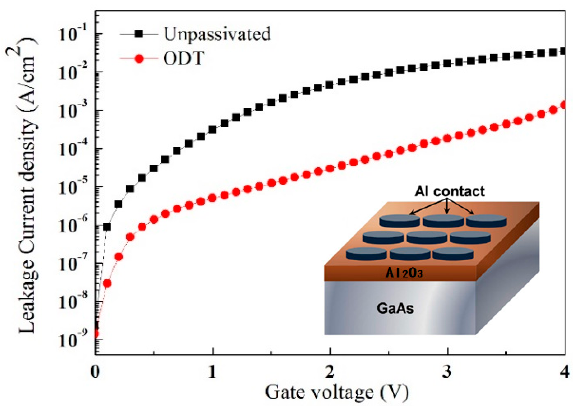
Figure 5. Leakage current density curve of Al/Al 2 O 3 /GaAs-MOSCAP.